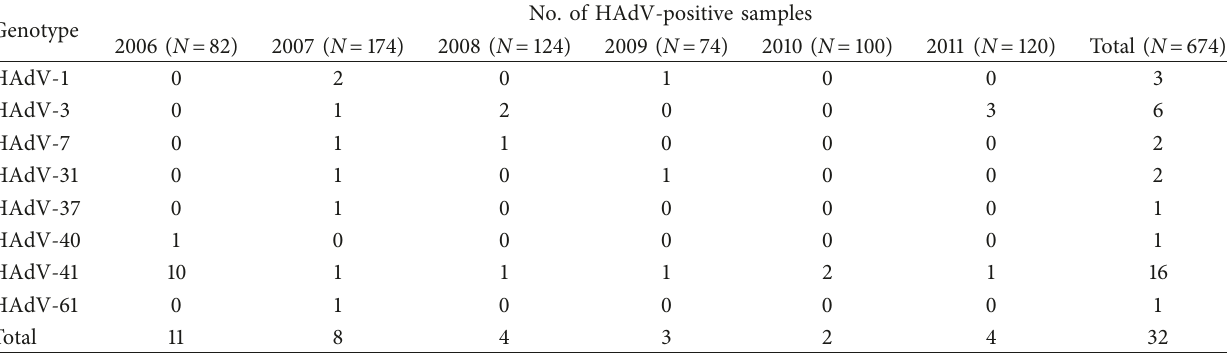
Table 1: Distribution of HAdV genotypes in hospitalized children with acute diarrhea from 2006 to 2011.